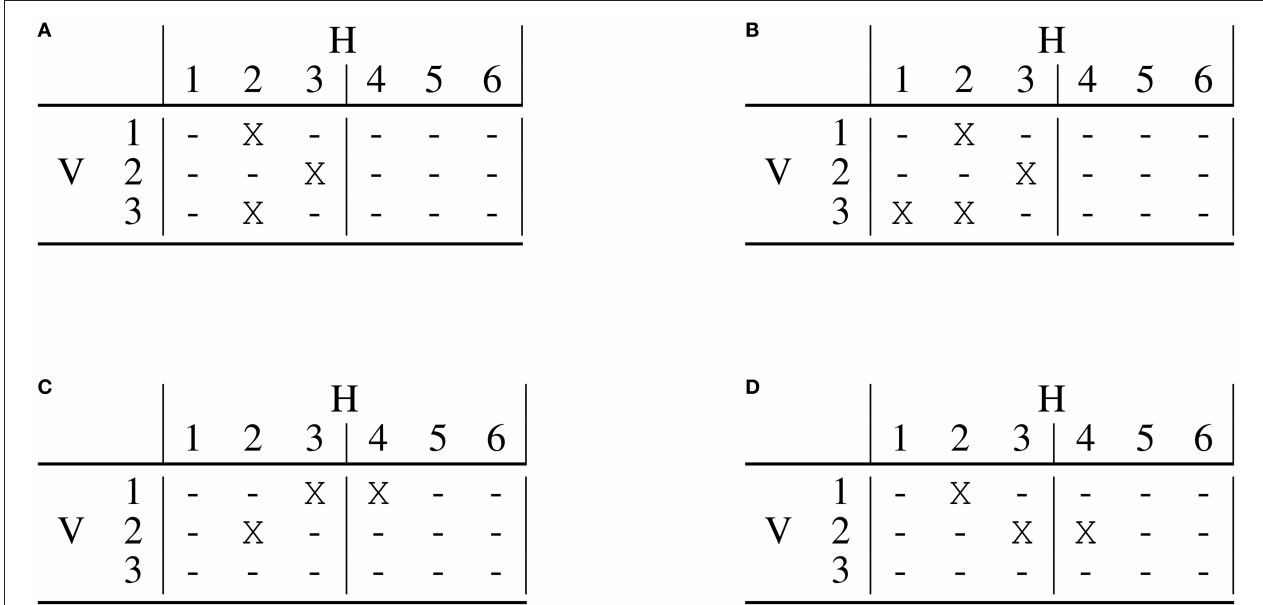
FIGURE 6 | A small user interface with 3 carousels, each with 6 elements on which the behavior of DCG and 2DCG is compared. Correct recommendations are represented with “ X ” while incorrect ones by “-”. ”. The vertical line between columns 3 and 4 represents the limit of the area initially visible to the user, i.e., V h = 3. (A,B) Represent the same layout in which (B) contains an additional correct recommendation in position (3, 1). (C,D) Represent two different layouts created based on the same three recommendation lists, with DCG preferring layout (C) and 2DCG preferring layout (D) due to the effect of the user action penalty on the correct recommendation in column